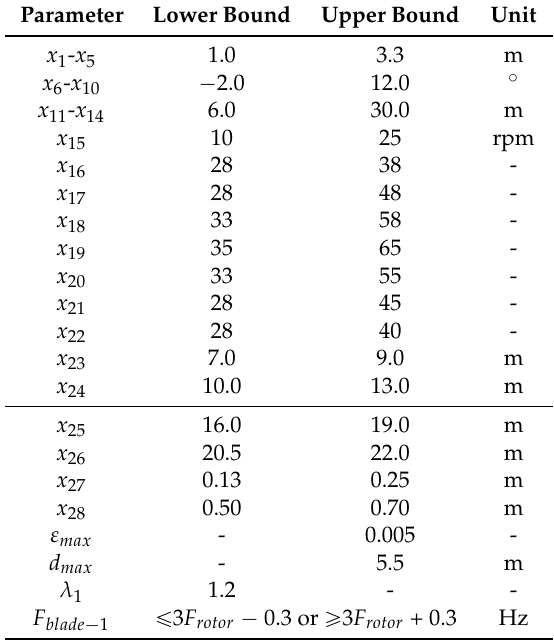
Table 3. Lower and upper bounds of the variables and the constraint